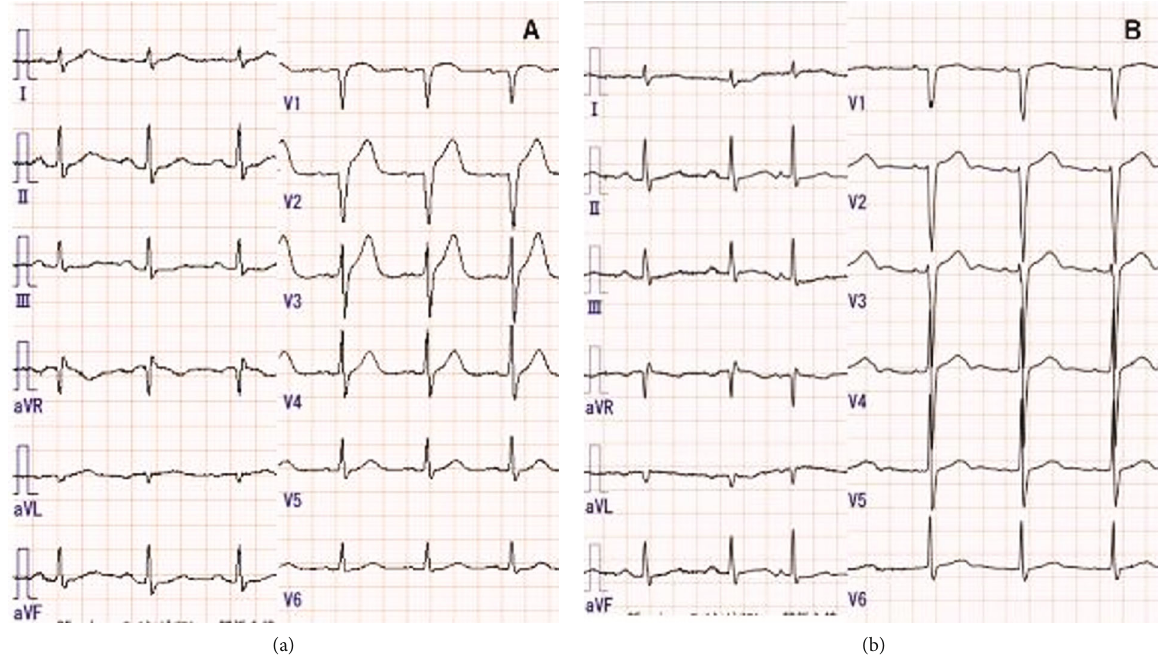
Figure 2: Electrocardiography fi ndings. (a) ST-segment elevation in leads V2 – 4 during a heart attack. (b) After lingual nitroglycerin therapy, ST-segment elevations